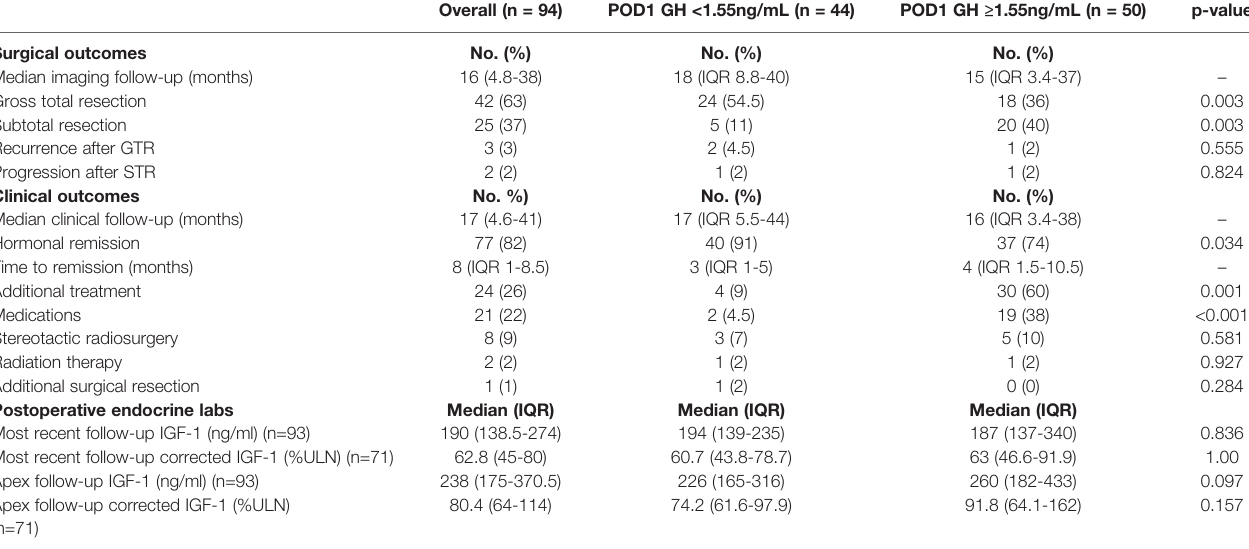
TABLE 4 | Overall surgical and clinical outcomes and comparisons based on POD1 GH cutoff of